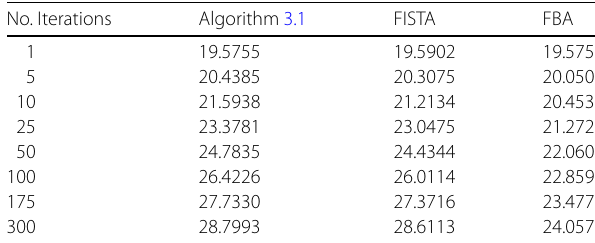
Table 2 The values of PSNR at x 1 , x 5 , x 10 , x 25 , x 50 , x 100 , x 175 , x 300 (Wat Chedi Luang) No. Iterations Algorithm